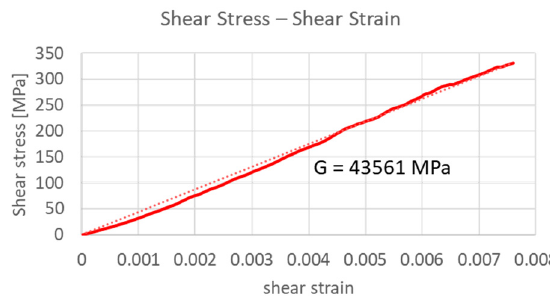
Figure 15. Material properties of austenite. Table 4. Specific material values for austenite.